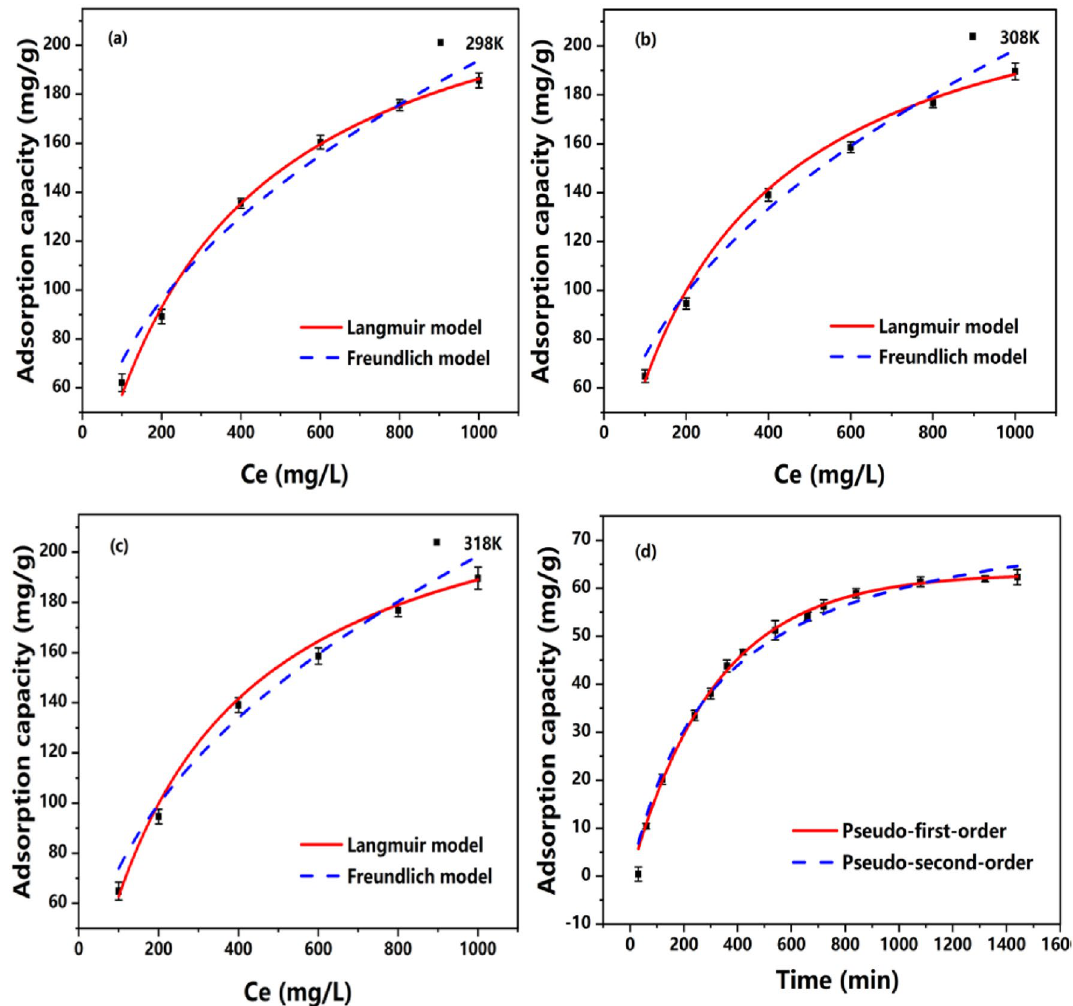
Figure 4. Influence of contact time on Cr(VI) sorption by IMC800-1 ( a ), the fit results of Langmuir and Freundlich models for IMC800-1 ( b – d ).